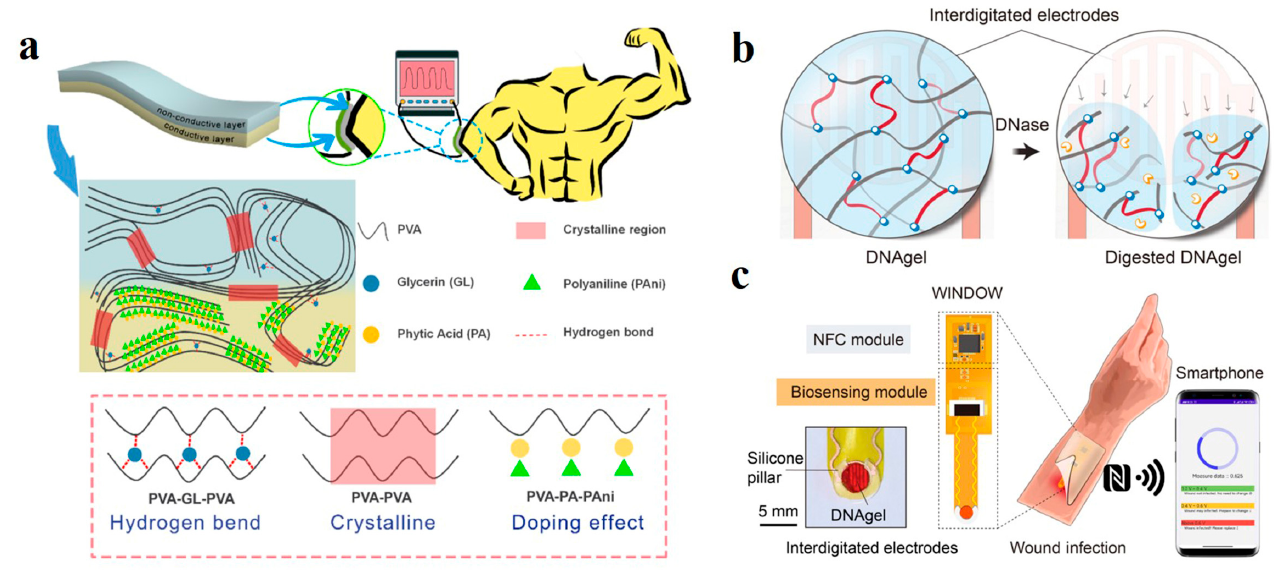
Figure 11. ( a ) Schematic diagram of double hydrogel protecting skin. Reprinted with permission from Reference [133]. ( b ) The breaking mechanism of DNA hydrogel. ( c ) The principle of wireless communication. Reprinted with permission from Reference [134].